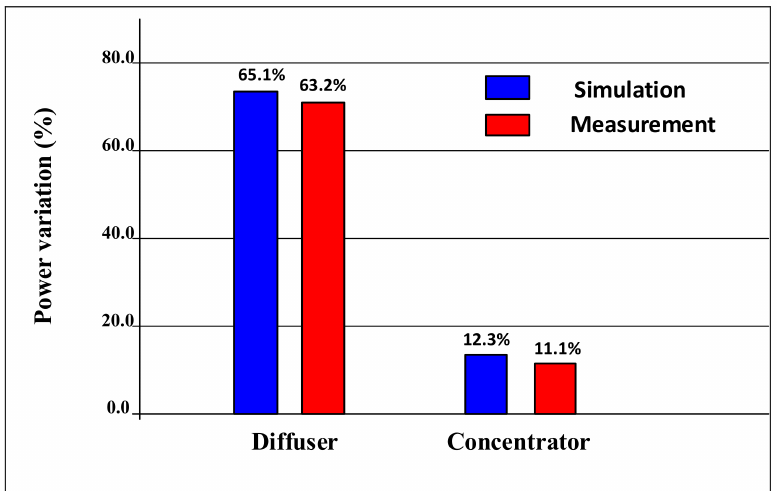
Figure 18. A comparison of the power